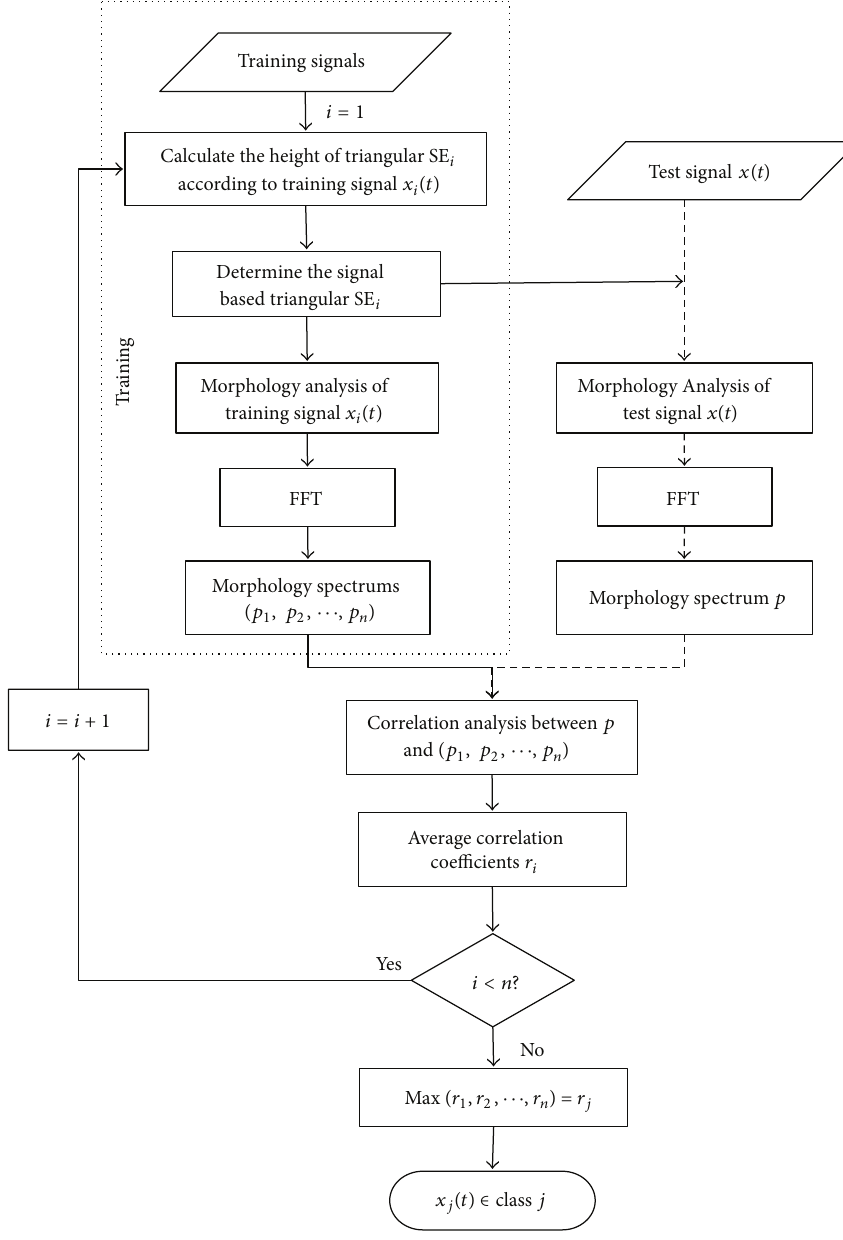
Figure 3: The fault diagnosis